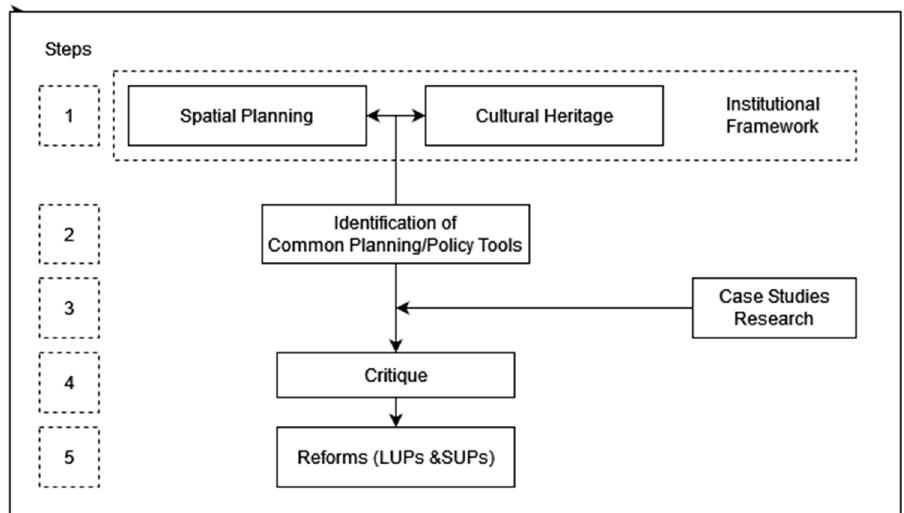
Figure 2. The methodological framework of the article. Source: Own Elaboration.